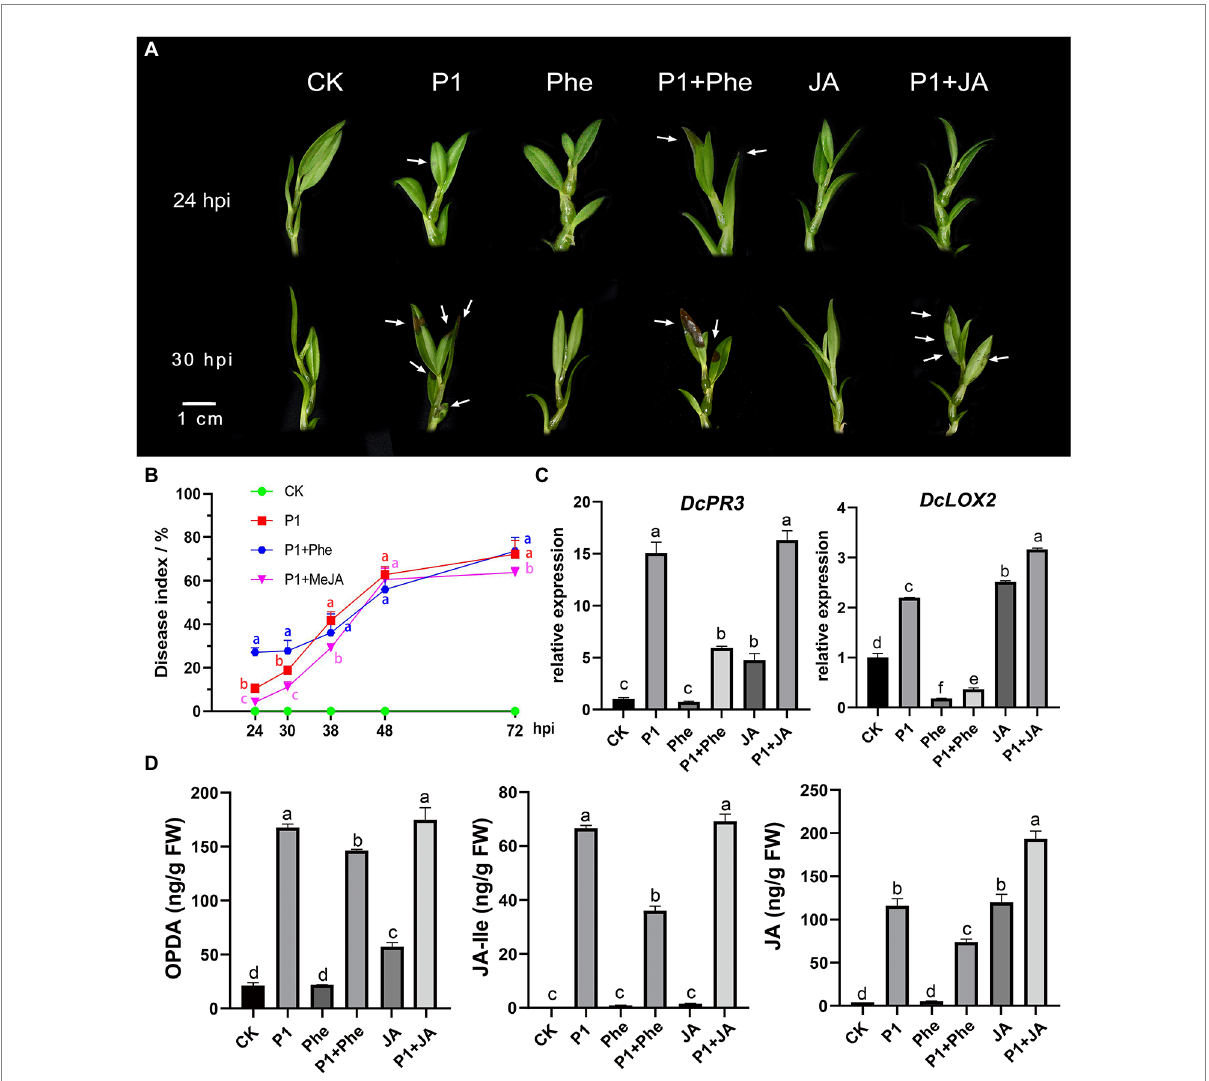
FIGURE 5 Enhanced resistance of D. catenatum to P1 infection by JA. (A) Disease symptoms of D. catenatum plantlets pre-treated with Phe (16 mmol/L) or MeJA (100 μ mol/L) following inoculation with S. delphinii at 24 and 30 hpi. Arrows point to the lesion. Bar = 1 cm. (B) Disease indexes line charts of the MeJA- or Phe-pre-treated D. catenatum were determined from 24 hpi (1 dpi) to 72 hpi (3 dpi). The values are the mean ± SD; n = 10. “abc” indicates a significant difference at p = 0.05. (C) The expression of important downstream gene DcPR3 , DcLOX2 of JA signaling pathway under different treatments through RT-qPCR assay. CK: control. P1: 24 h post-inoculation with S. delphinii. JA: pre-treated with MeJA for 4 h and then inoculated with sterile distilled water for 24 h. P1 + JA: pre-treated with MeJA for 4 h and then inoculated with S. delphinii for 24 h. Phe: pre- treated with MeJA for 4 h and then inoculated with sterile distilled water for 24 h. Phe + P1: pre-treated with Phe for 4 h and then inoculated with S. delphinii for 24 h. The actin gene of D. catenatum was used as an internal control. The error bars indicate SD from three independent experiments. The “abcdef” showed a significant difference at p = 0.05 compared with the CK. (D) Content of oxophytodienoic acid (OPDA),